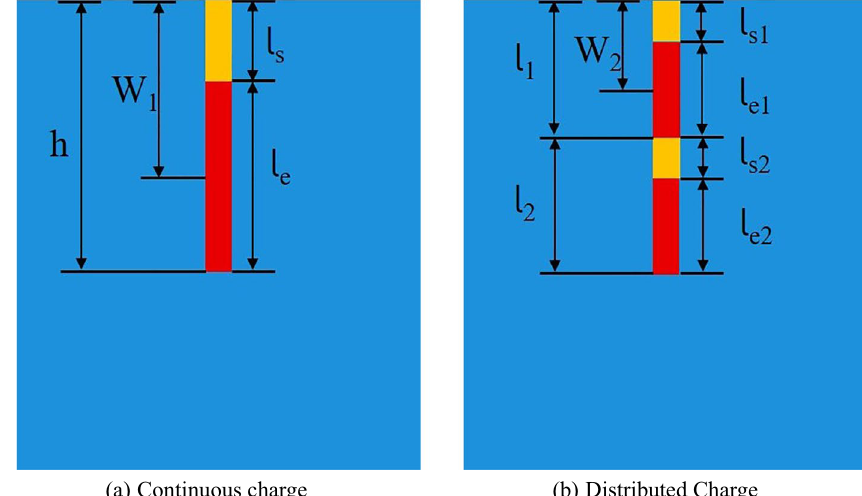
Fig. 2 Charge structure comparison. a Continuous charge b Distributed